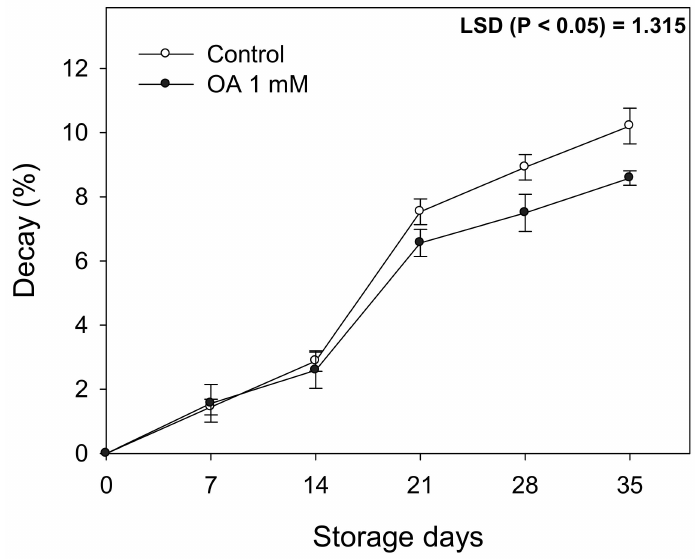
Figure 4. The incidence (%) of decayed lemons from the trees treated with oxalic acid (OA) 1 mM and in the controls. Data are the mean ± SE. LSD show significant differences at p <